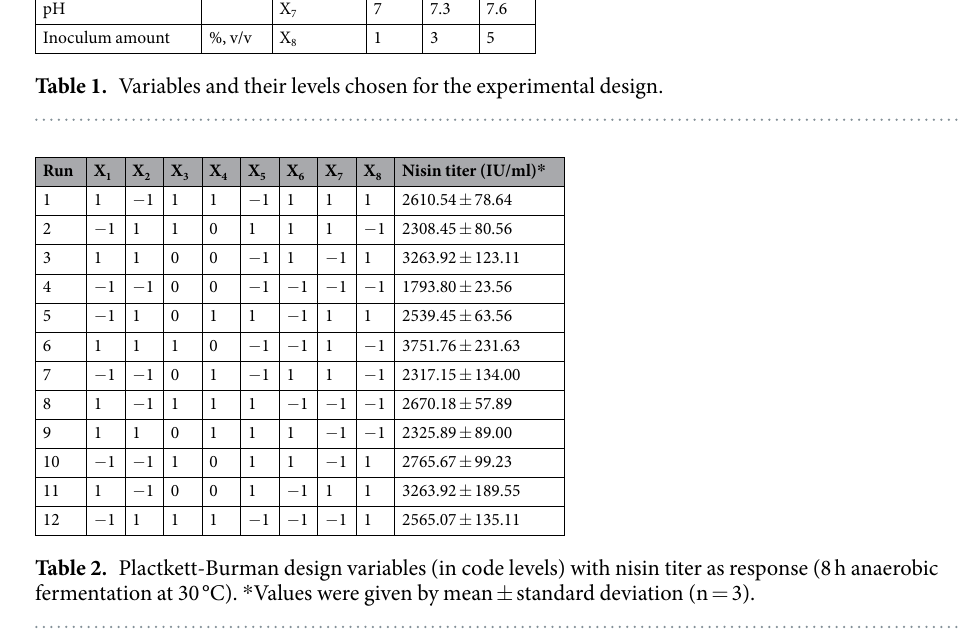
Table 2 showed the design matrix and its corresponding results. The production of nisin varied from 1793 IU/ml to 3751 IU/ml under different levels of factors, which indicated that the parameters of fermentation could directly affect nisin production. The regression analysis of variance (ANOVA) based on the experimental data was shown in Table 3. The coefficient of determination R 2 of the model was 0.9608, which explained 96.08% of the response variability. The significance of corresponding variable was determined by p -values and p -values of less than 0.05 were considered to be significant effects on the response. As shown in Table 3, the p -value of X 3 and X 8 was 0.029 and 0.013, respectively. Both of them were less than 0.05, indicating that the concentration of KH 2 PO 4 (X Central composite design (CCD). The experimental design and results of CCD were presented in Table 4. The regression analysis of a full second-order polynomial model was shown in Table 5. The F-value of the model was 20.46, which implied that the model was so significant that there was only 0.05% chance for the model to occur due to noise. Additionally, with a relatively high value of the determination coefficient (R 2 = 0.9359), the model fitted to experimental results very well that provides a good estimation of nisin yield. The term was regarded as significant with a p -value less than 0.05. In this case, the linear and quadratic of X 3 , X 8 , X 32 , X 82 (p < 0.05) were recognized as the significant model terms, suggesting that K 2 HPO 4 and inoculum amount play a significant role on nisin production by culture of L . lactis F44, However, their interaction between K 2 HPO 4 and inoculum amount (X 3 X 8 , p > 0.05) was insignificant on nisin production. The quadratic equation illustrates the relationship between KH